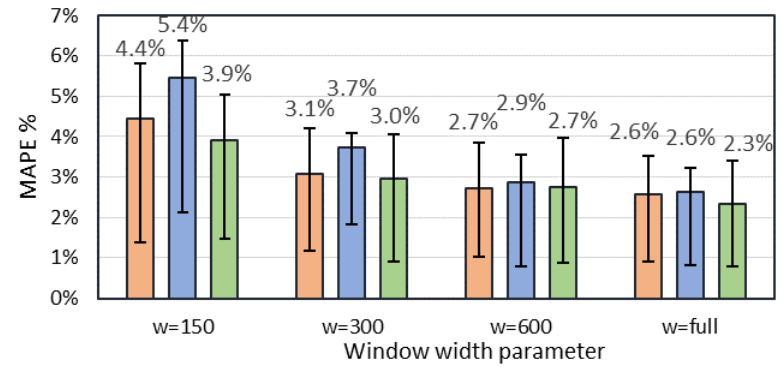
Figure 10. Speed error MAPE versus cropping algorithm window parameter for three different average speed groups. Error bars indicate a percentage error range of second and third quartiles.